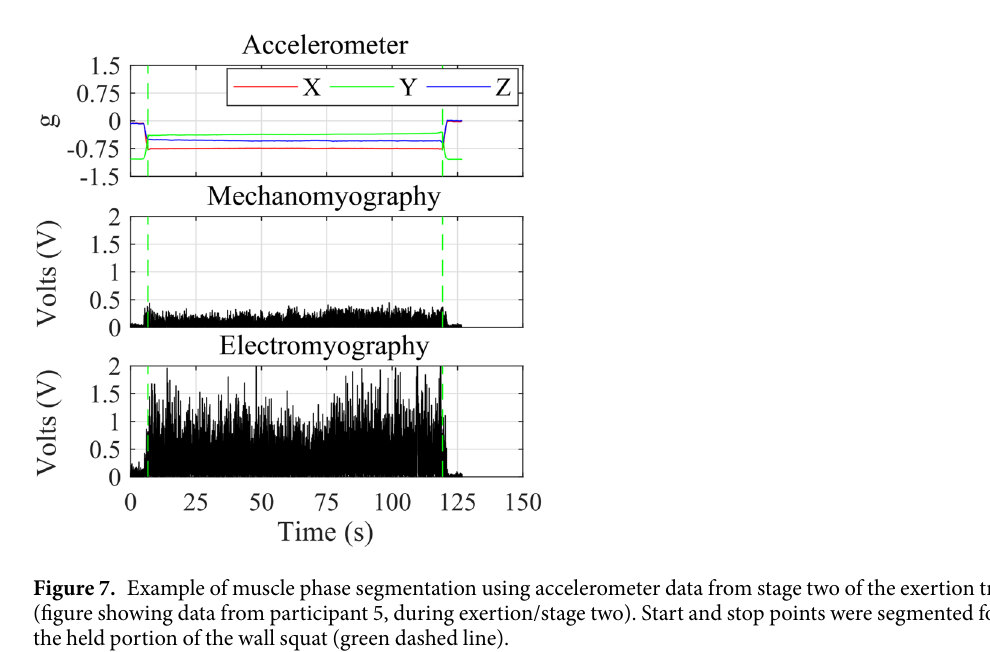
Figure 6. Example of muscle phase segmentation using accelerometer data from stages one and three of the exertion trial (figure showing data from participant 5, pre-exertion/stage one). Each repetition was detected and the start and stop points were segmented for entering (red dot-dashed line), held (green dashed line), and exiting (blue dotted line) the squat.